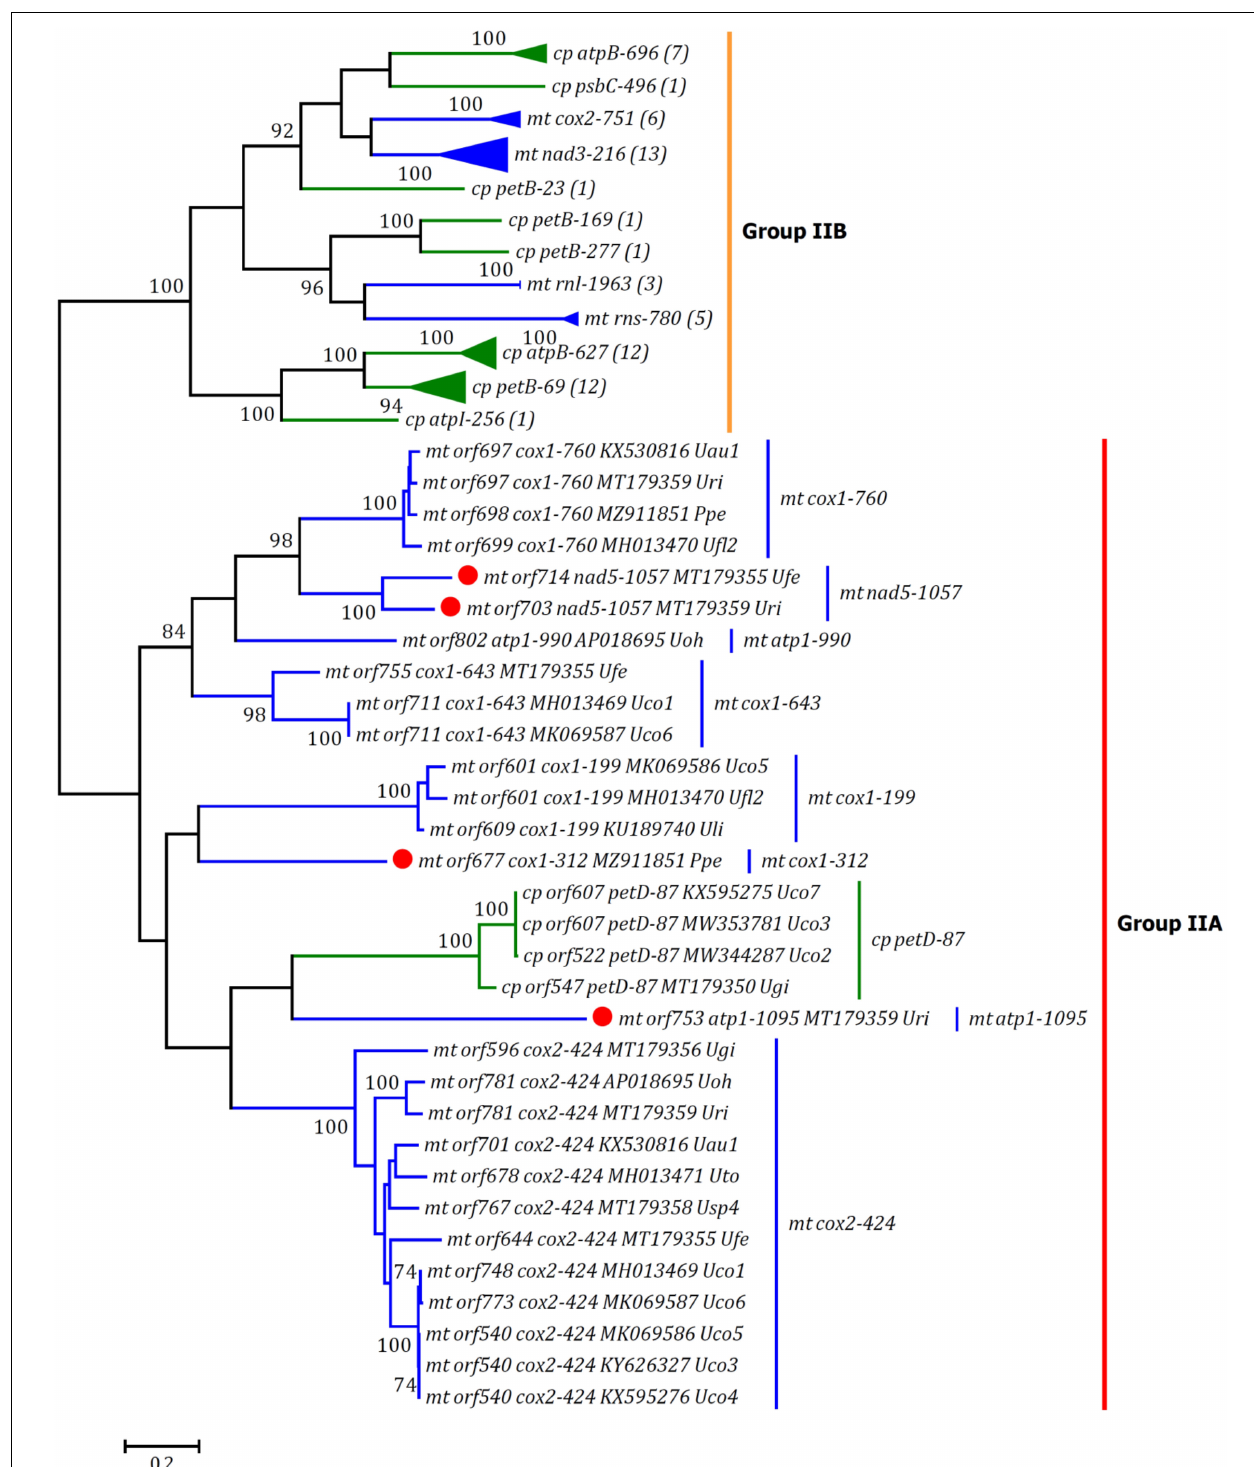
FIGURE 6 | Unrooted phylogenetic tree based on Maximum Likelihood (ML) analysis of amino acid (aa) sequences of 94 reverse transcriptase (RT) domains (54 in mtDNAs and 40 in cpDNAs) from group IIA/IIB introns. RT domains from mtDNAs were shown in blue and RT domain from cpDNAs in green. Numbers within parentheses in group IIB clade indicated the number of RT domains found in each cognate intron family. The ML analysis was conducted with 1,000 bootstrap replicates using MEGA 7.0. The bootstrap support values greater than 70% were displayed at branches. Branch lengths were proportional to the amount of sequence change, which were indicated by the scale bar below the